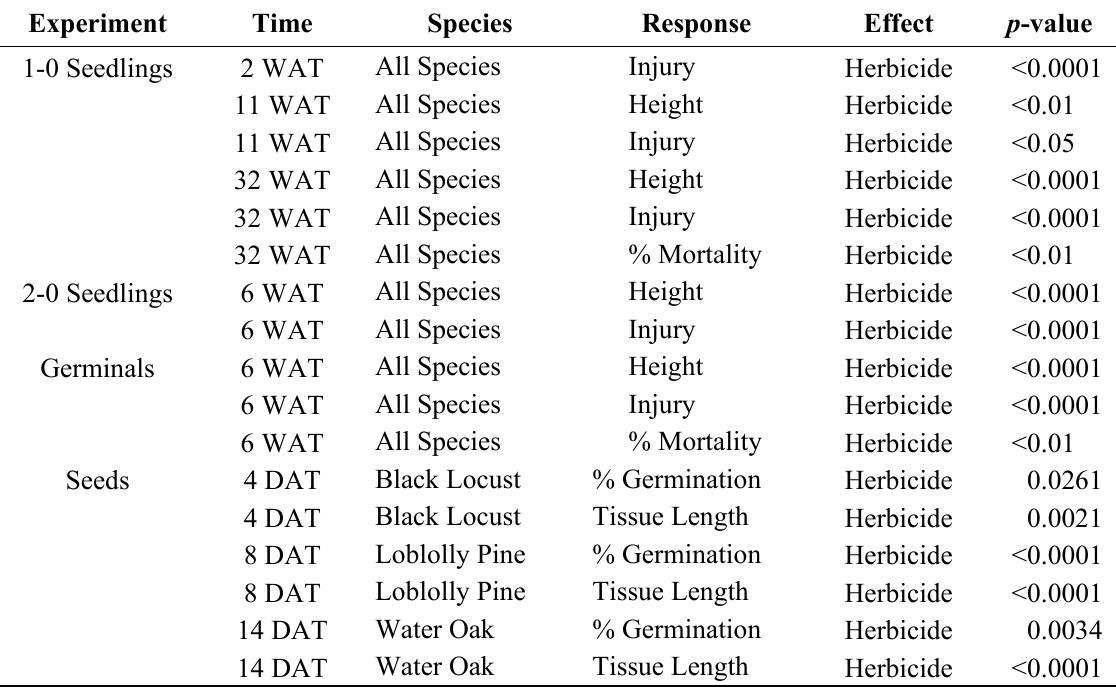
Table 4. Summary table of ANOVA outputs from rapid screening trials †